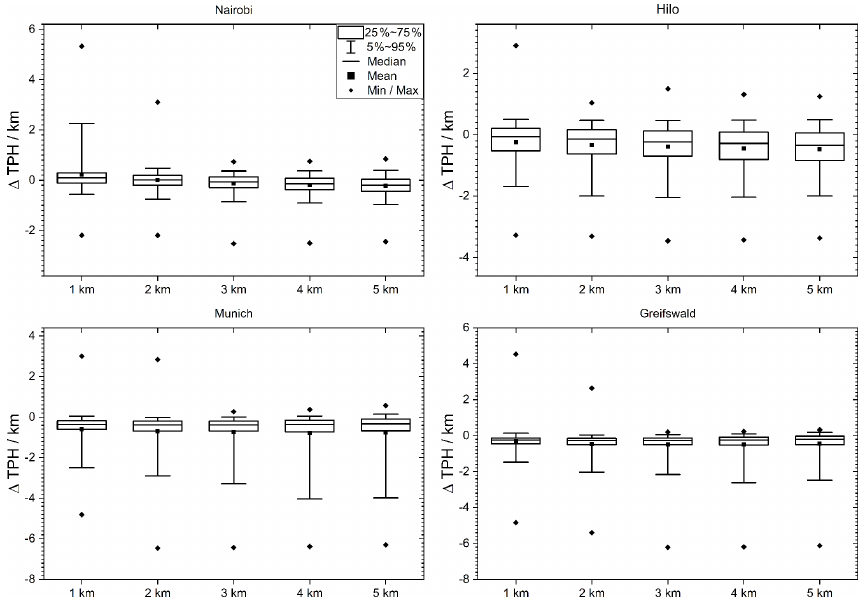
Figure 3. The lapse rate tropopause displacement for four geolocations as a function of vertical resolution for Gaussian kernels. Boxes represent both the second and the third quartiles. The “error bars” represent the central 90%